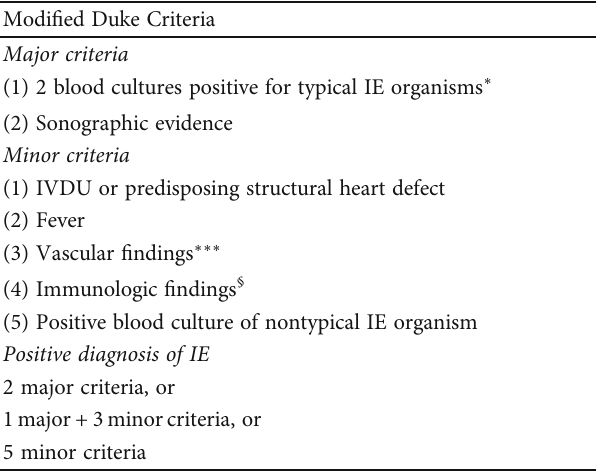
Table 2: Modi fi ed Duke